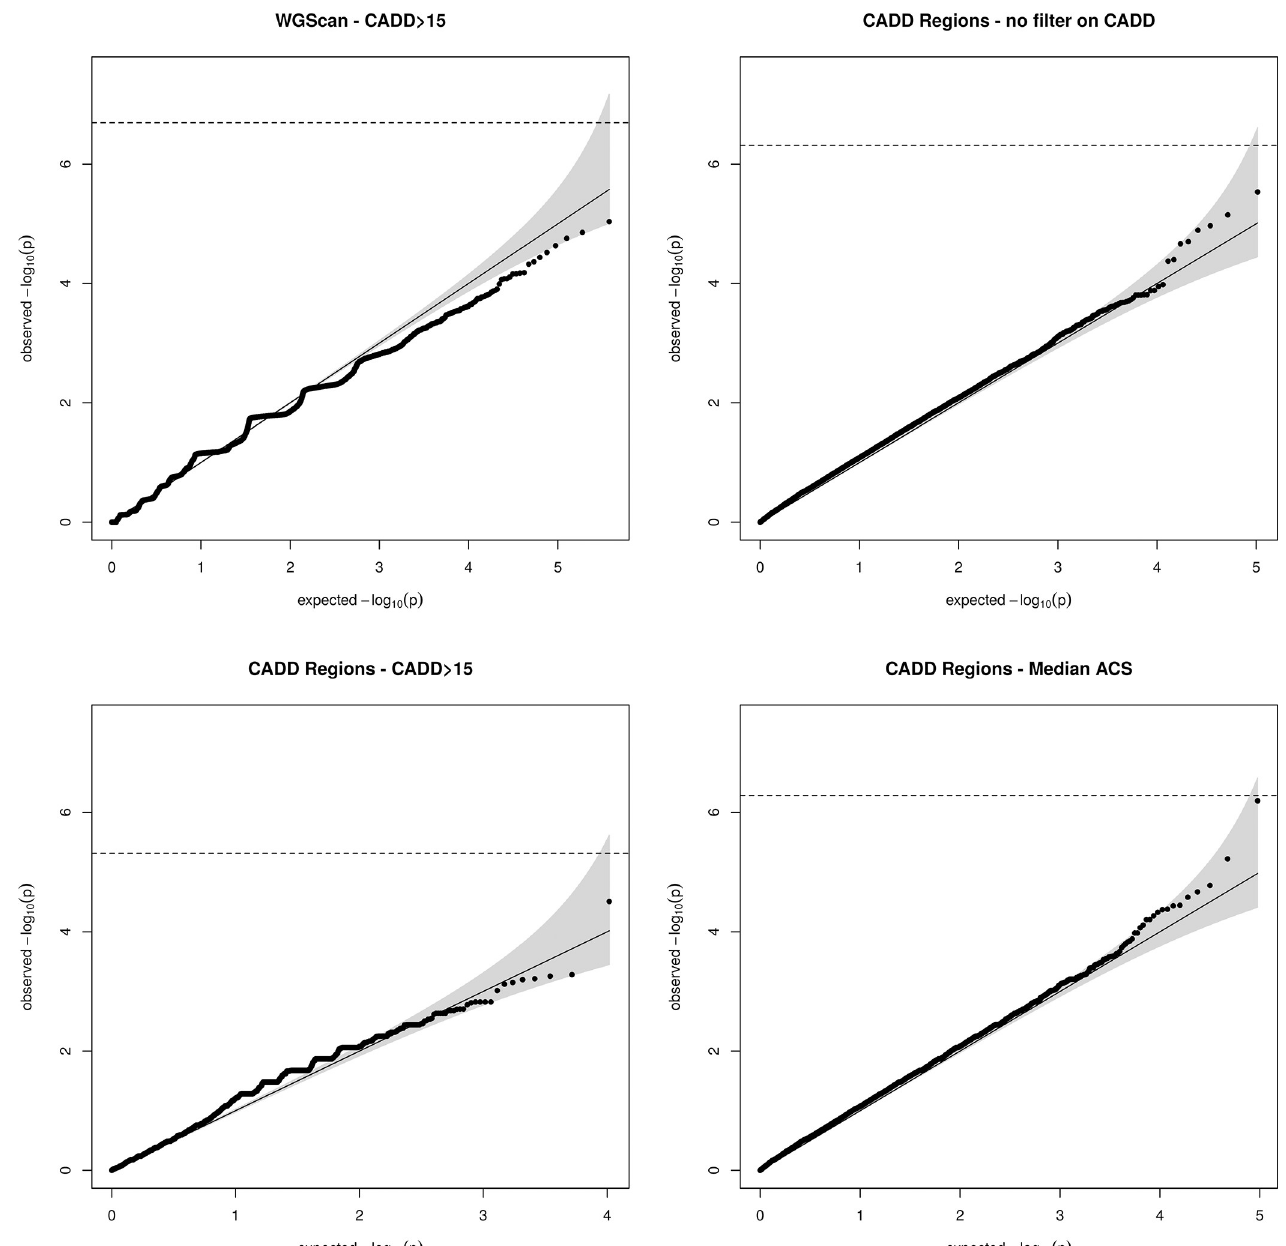
Fig 3. QQ-plot of WSS analyses on VTE data using the four strategies of analysis. Early-onset patients ( < 50 years old) were compared to late-onset patients ( � 50 years old).